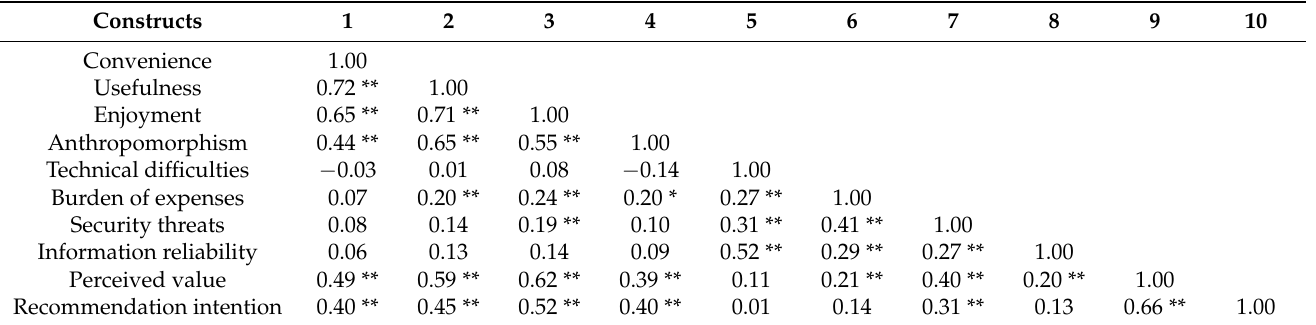
Table 5. Correlation analysis